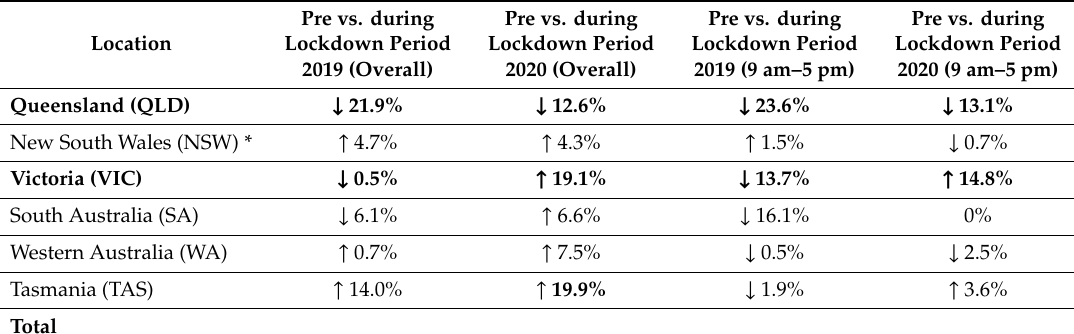
Table 6. Comparison of percentage increases / decreases in energy use between 21 March to 11 May versus 1 February to 19 March in 2019 and 2020, for both overall energy use and energy use between 9 am–5 pm